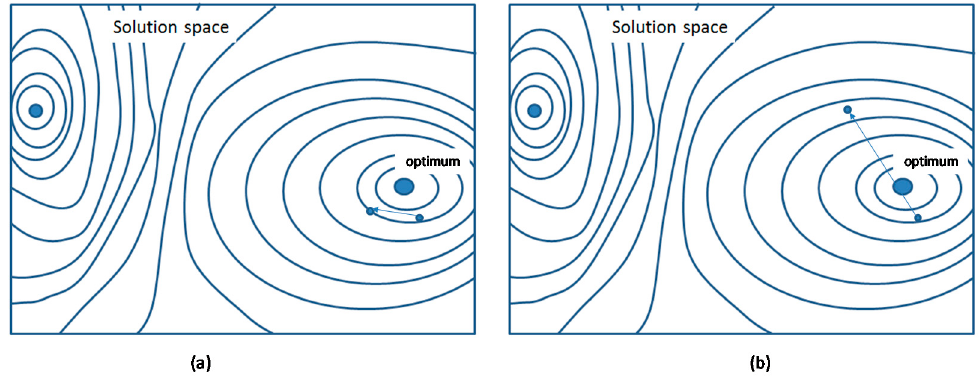
Figure 3. ( a ) A small mutation. ( b ) A large mutation.